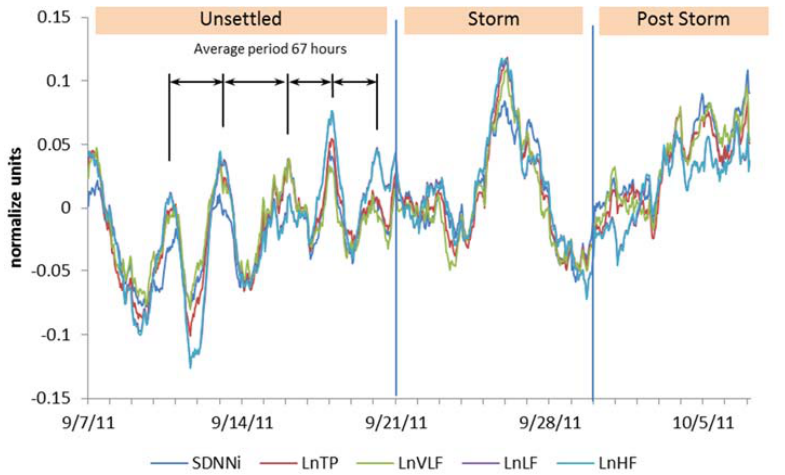
Figure 2. Slow wave HRV synchronization in the participants’ averaged SDNNi, TP, and VLF, LF, and HF power waveforms over the 30 ‐ day period.